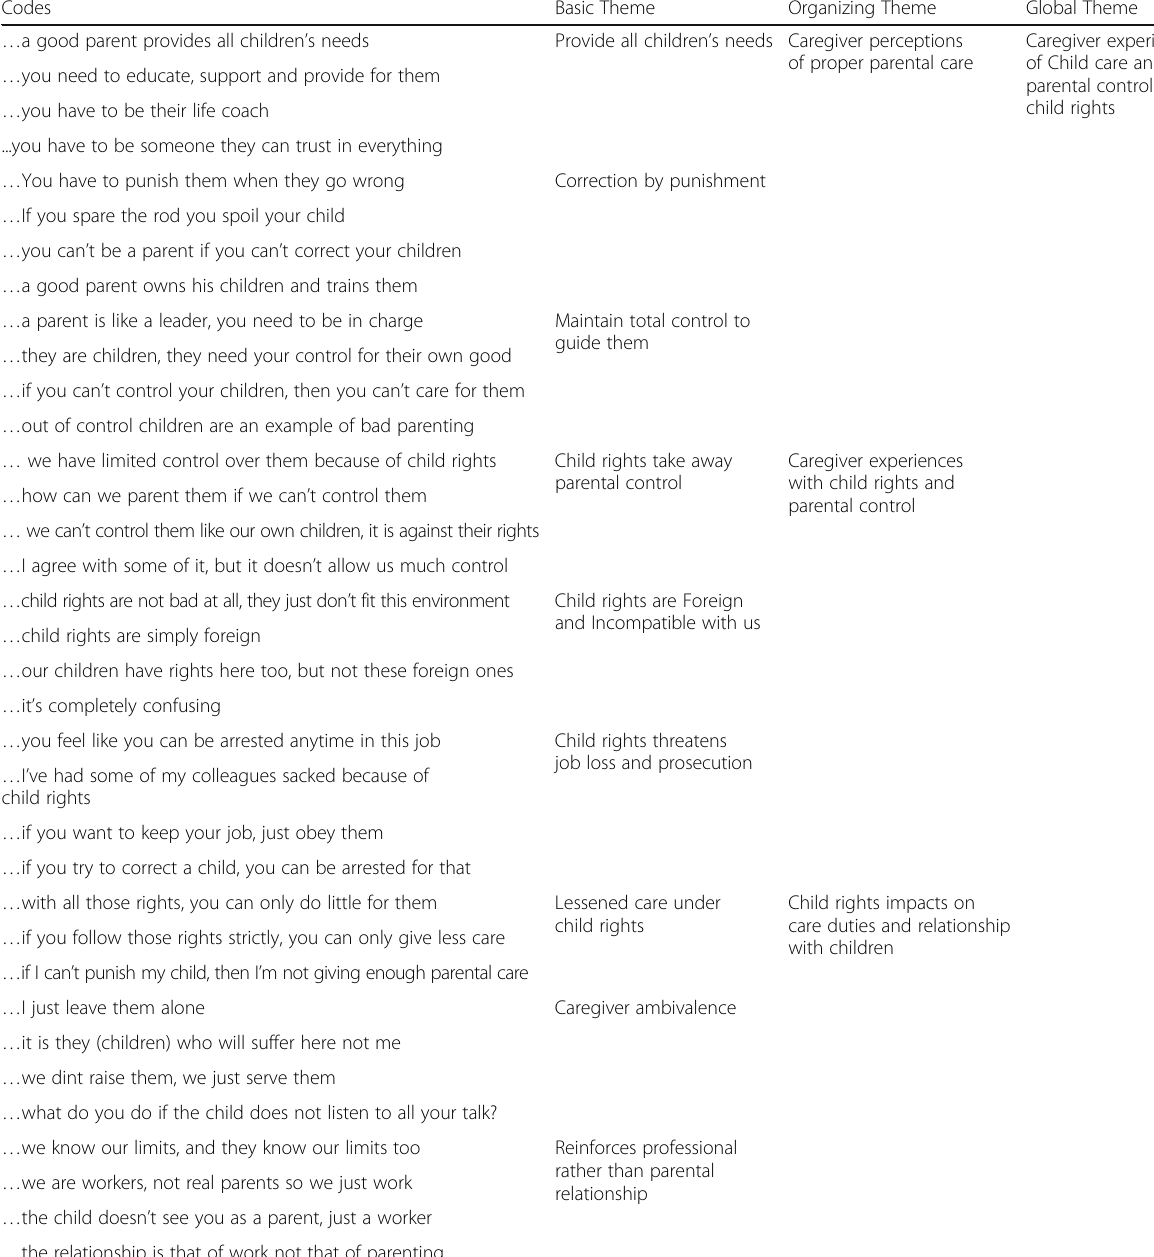
Table 2 Thematic Network Analysis (TNA) of collected data